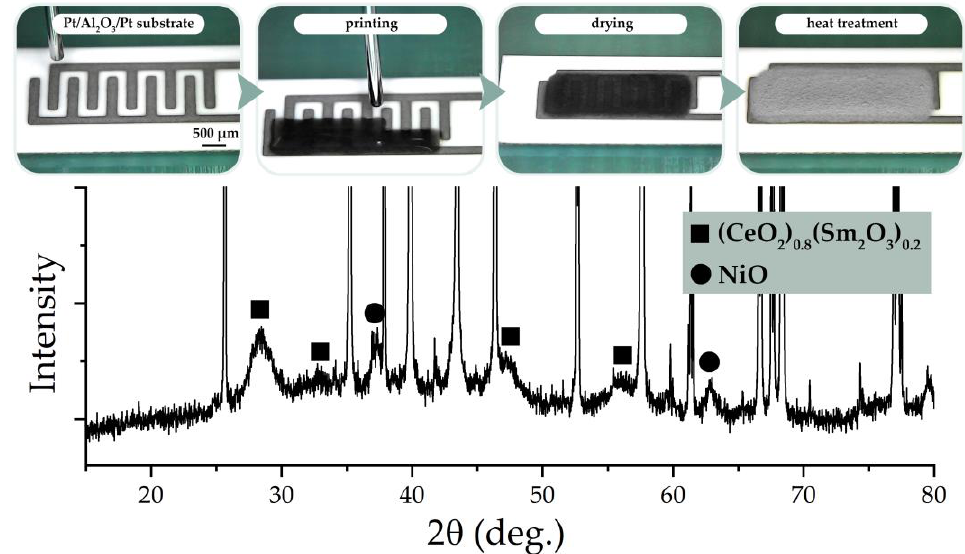
Figure 6. Microextrusion printing process of the ((CeO 2 ) 0.8 (Sm 2 O 3 ) 0.2 )@NiO composite anode film (top) and the corresponding X-ray diffraction pattern (bottom). ( top ) and the corresponding X-ray diffraction pattern ( bottom